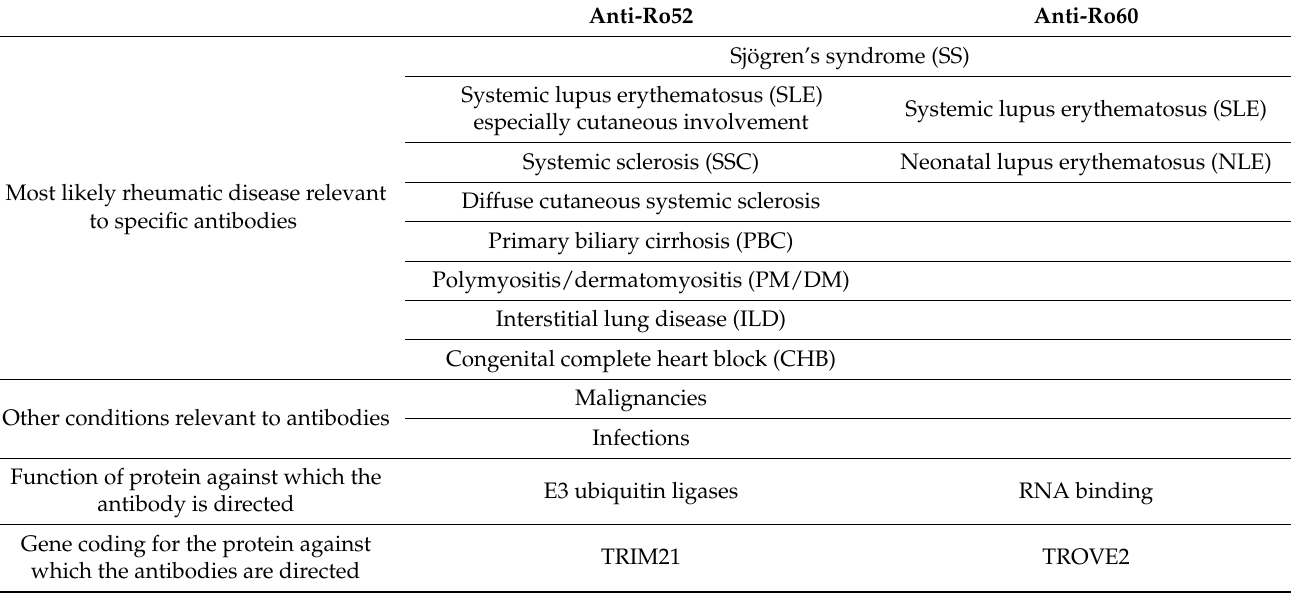
Table 1. Difference between anti-Ro52 and